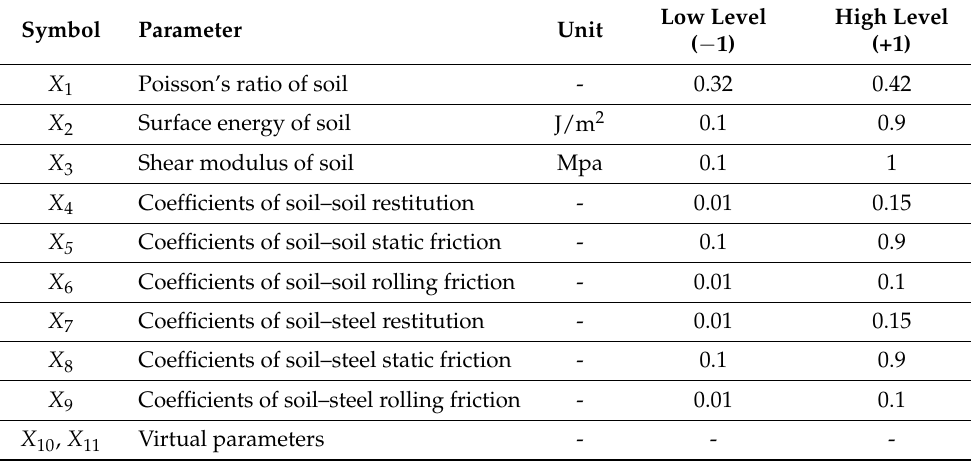
Table 1. Parameters and corresponding value ranges in the Plackett–Burman